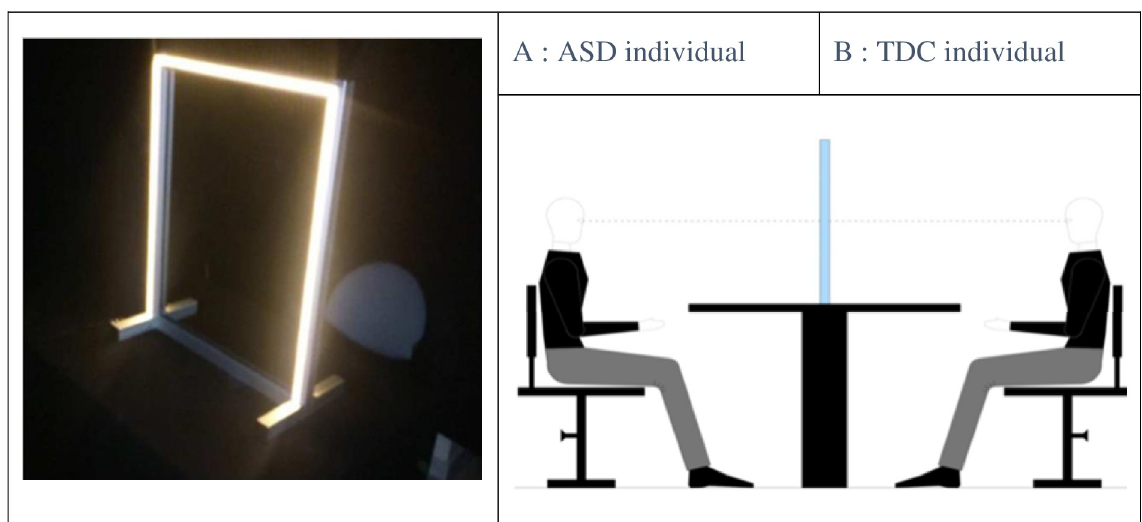
Fig 1. Experimental setting. a. Picture of the double mirror Alter Ego designed by Moritz Wehrmann. The experiment took place in a completely darkened enclosed space in the research centre of the Brest Hospital. The mirror was installed on a square table. The ASD patient and his matched control sat facing each other on either side of the double mirror. b. Schematic representation of the individuals during the recognition task. Both participants wore a black cape covering the neck, the whole chest and the arms so that only the face was visible. They were asked to look each other straight in the eye and to focus only on the other person’s face. Height-adjustable chairs allowed strict alignment of the eyes.